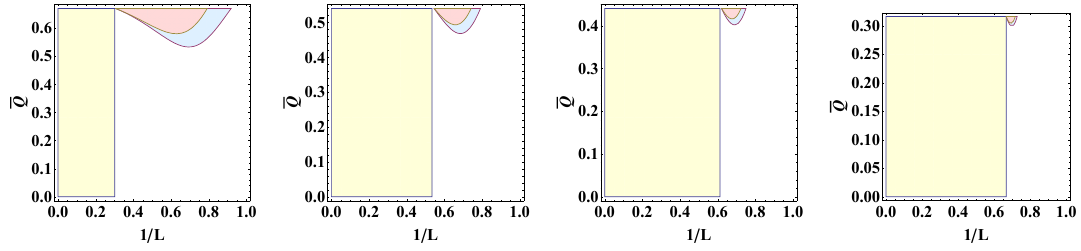
0.0 0.2 0.4 0.6 0.8